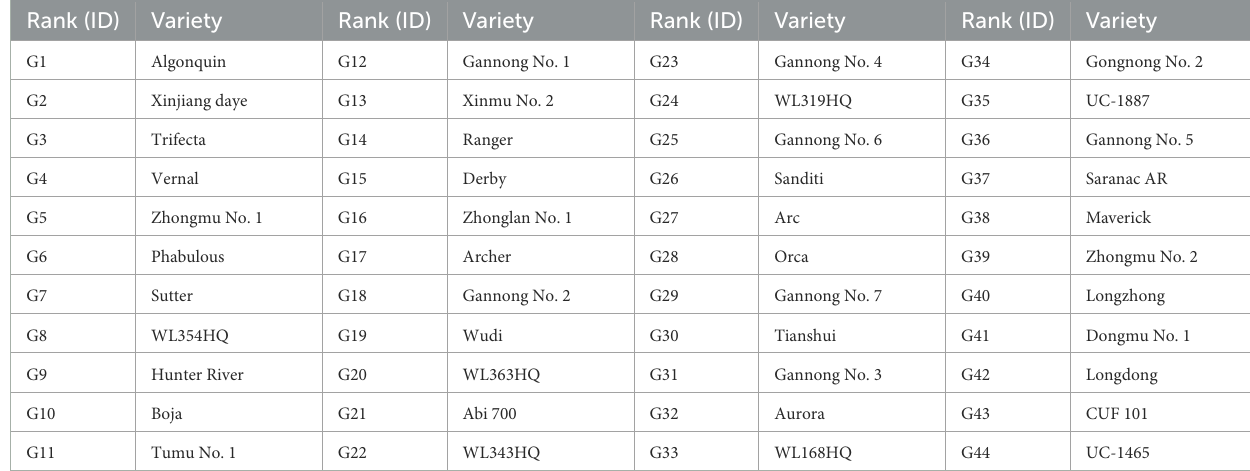
TABLE 2 GGE yield rankings from 44 varieties of alfalfa in 2019 and